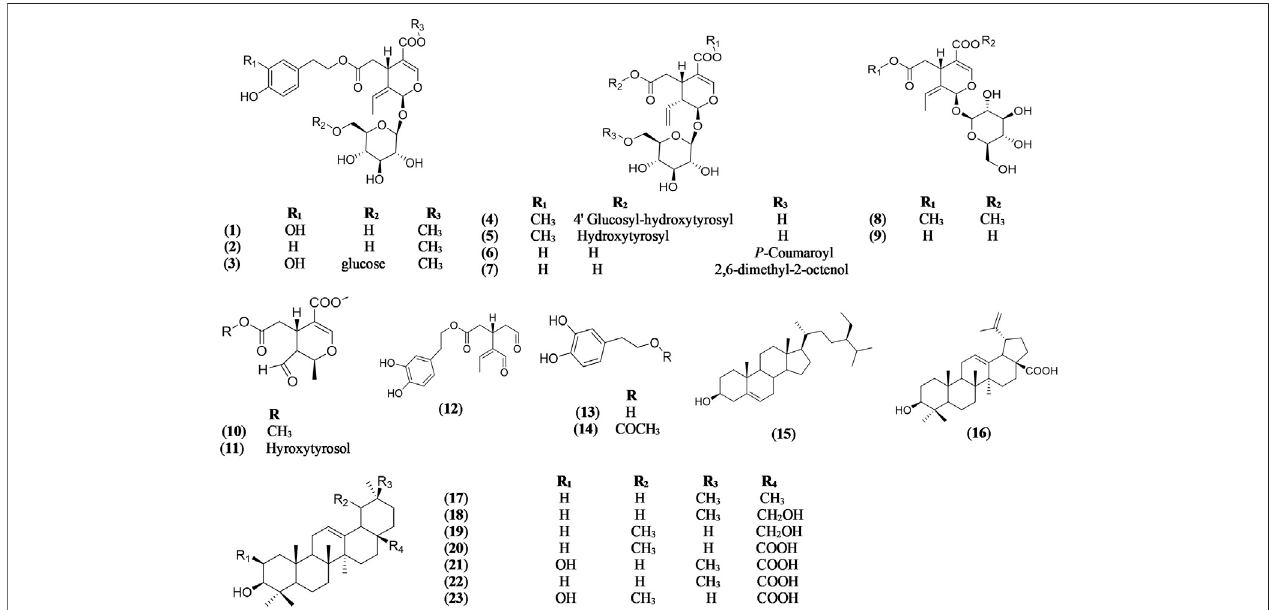
FIGURE 1 | Chemical structures of secoiridoids, triterpenoids, and steroids reported in Olea europaea leaves.